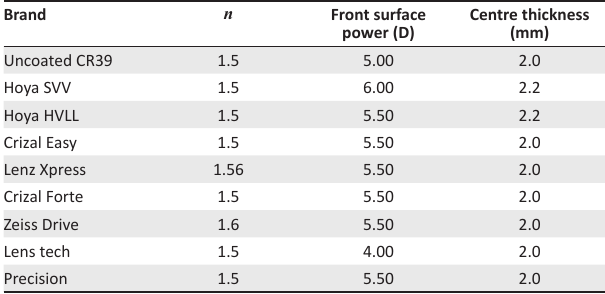
TABLE 1: Showing pre-coated stock lens parameters that were used for this study, which includes refractive index ( n ), front surface power (D) and centre thickness